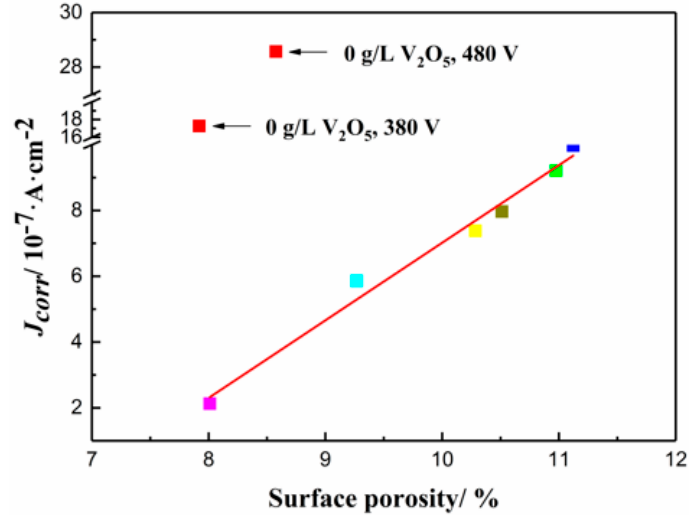
Figure 10. Scatter plot with the best correlations for surface porosity and corrosion current density data.